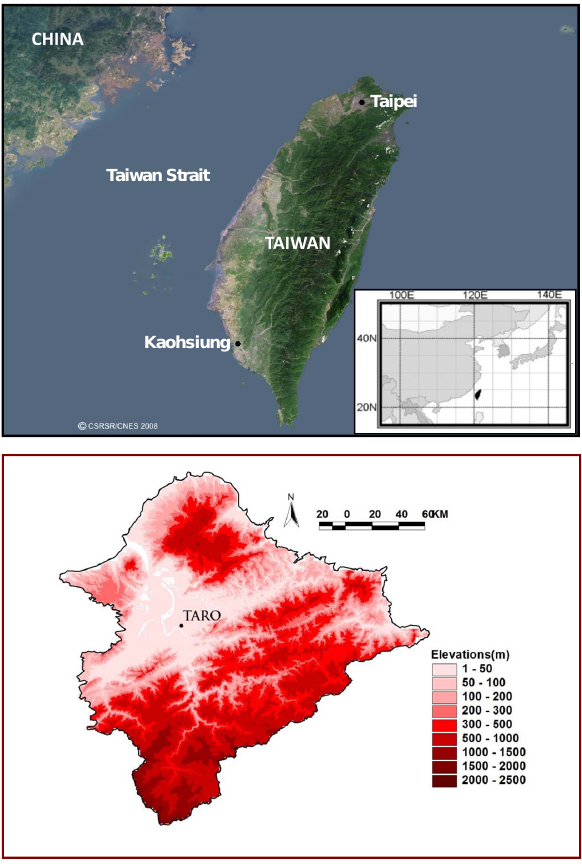
Fig. 1. Geographical locations of Taiwan in East Asia (upper panel) and the Taipei Aerosol and Radiation Observatory (TARO) in the Taipei basin (lower